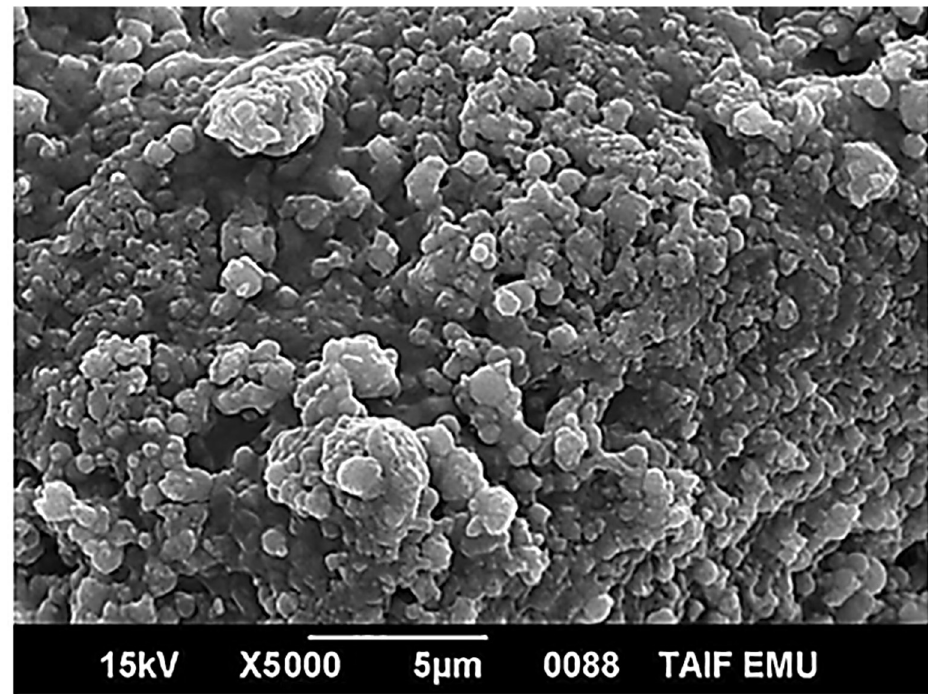
Figure 4. SEM image of TiO 2 nanoparticles.